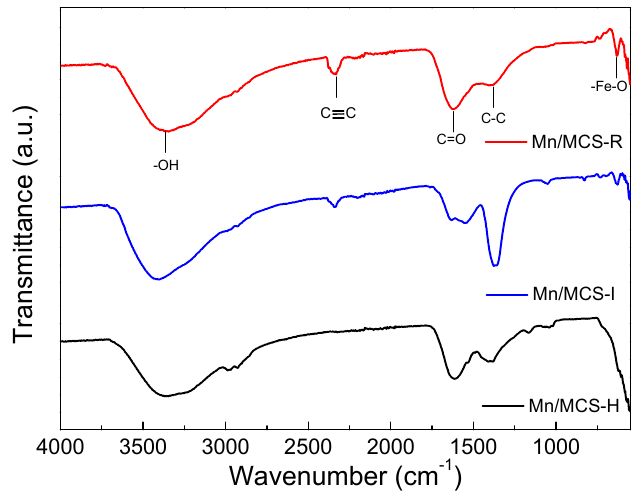
Figure 5. Fourier transform infrared spectroscopy (FT ‐ IR) spectra of three Fe 3 O 4 /C/Mn hybrids. Thermal stability of the three Fe 3 O 4 /C/Mn catalysts was investigated by TG ‐ DTA under air flow (Figure 6). For TGA profiles of Mn/MCS ‐ R and Mn/MCS ‐ H (Figure 6A,C), three obvious weight